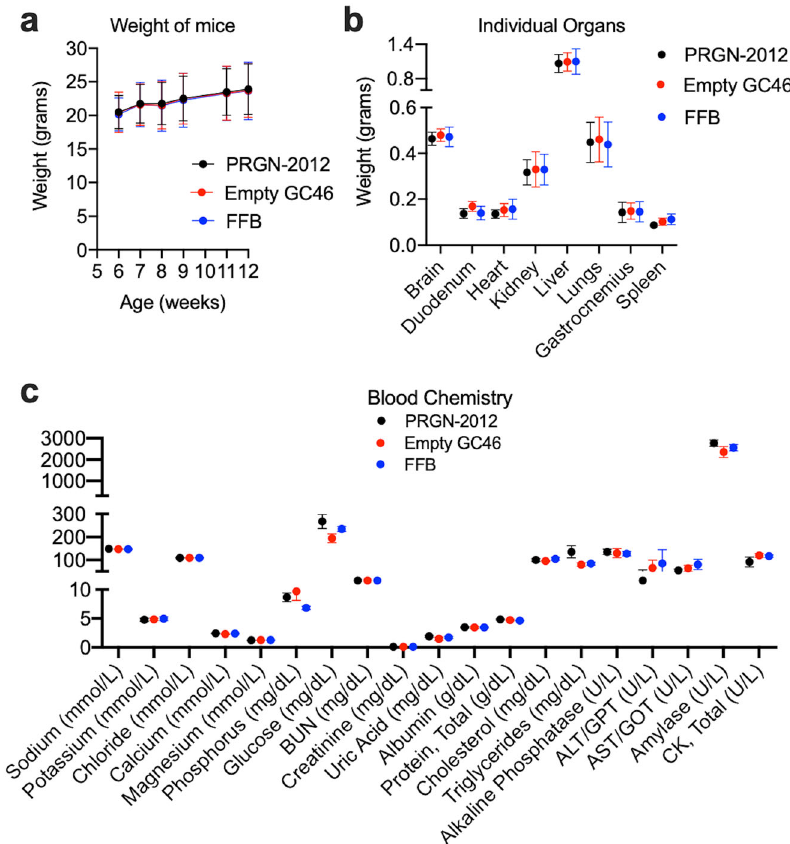
Fig. 2 No toxicity was observed following in vivo vaccination with PRGN-2012. Wild-type C57BL/6 mice were vaccinated with three doses of PRGN-2012 (10 10 VP), empty GC46 (10 10 VP), or FFB. a Body weight was assessed serially in vaccinated mice ( n = 5 male and 5 female mice/ group). 24 h after the fi nal vaccination with PRGN-2012, empty GC46, or FFB, b organs were harvested and weighed and c plasma/serum was collected for chemistries ( n = 5 male and 5 female mice/group). For chemistries, units of reported measurements are listed for each test on the x -axis. FFB fi nal formulation